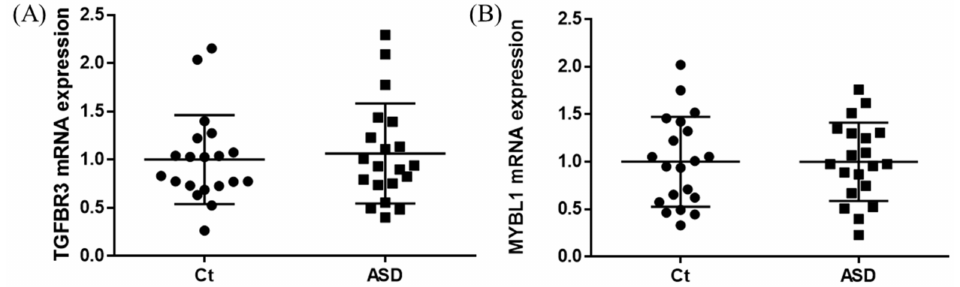
Figure 6. TGFBR3 and MYBL1 mRNA expression in replication cohort. The y -axis represents the ratio of the relative expression value of the control and ASD subjects for TGFBR3 ( A ) and MYBL ( B ). Ct, controls; ASD, autism spectrum